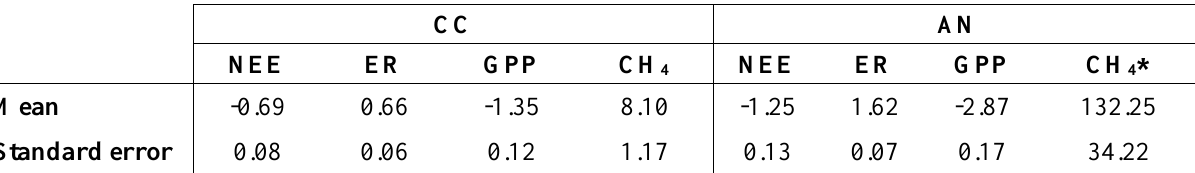
) flux is expressed in mg 4